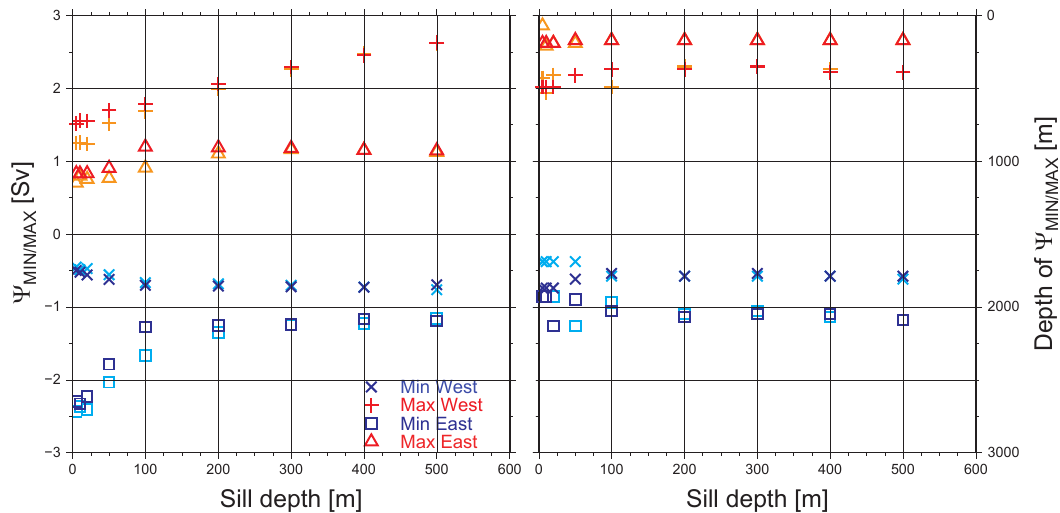
Figure 8. Strength (left) and depth of overturning extrema (right) of the upper (red) and deep (blue) zonal overturning cells in the western and eastern basin. To illustrate temporal changes, light colours indicate the value after 400yr, dark colours the value after 800yr.